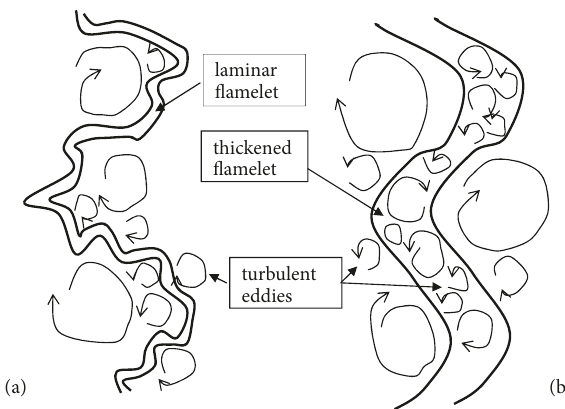
Figure 1: Laminar flamelet (a) and microturbulent (thickened) flamelet (b) combustion